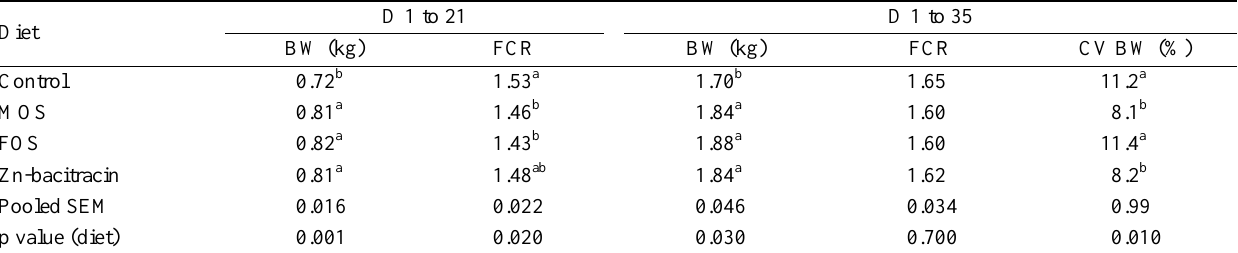
Table 2. Effects of oligosaccharides and antibiotic supplementation on BW gain, feed efficiency and flock uniformity at 21 and 35 d